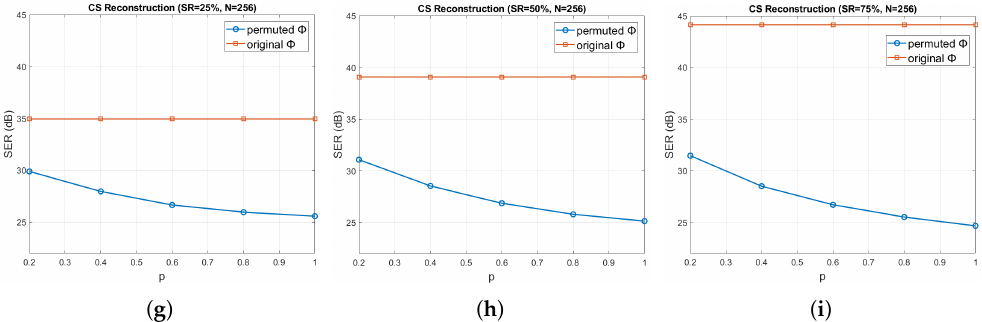
Figure 15. CS reconstruction error in terms of SER (dB) averaged over all streams, for the original and permuted Φ and for SR ∈ { 25%,50%,75% } , as a function of p ( % ) : ( a – c ) N = 64; ( d – f ) N = 128; and ( g – i ) N =